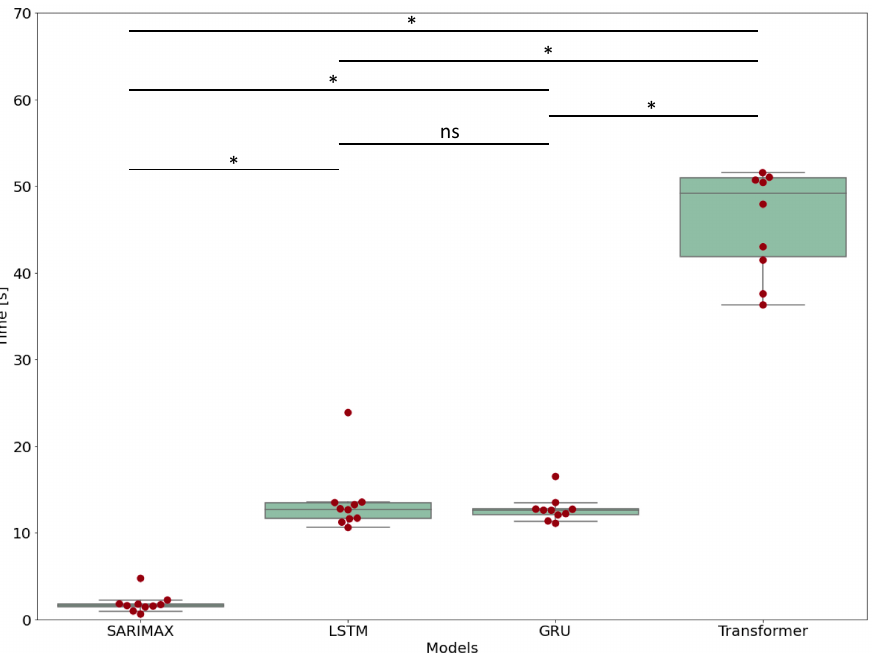
Figure 9. Computational time distribution for each model, with pairwise comparison, where * stands for a p -value < 0.05. ns: not